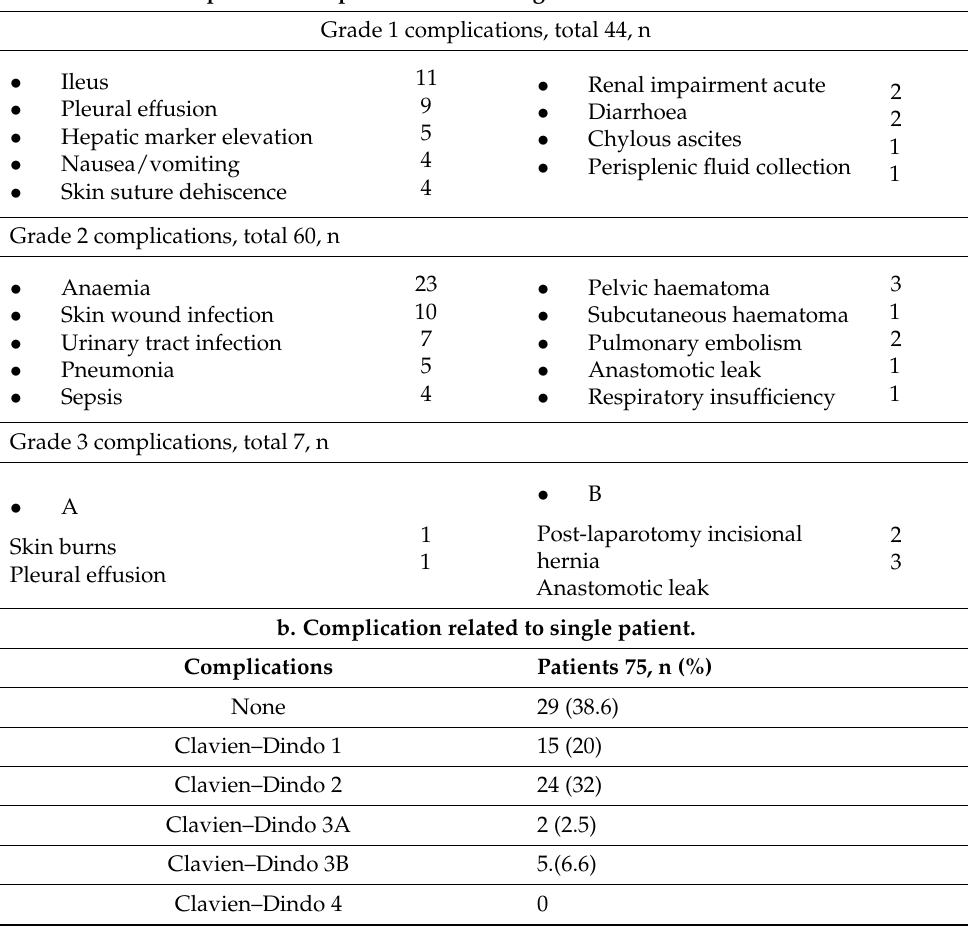
Table 4. Complication